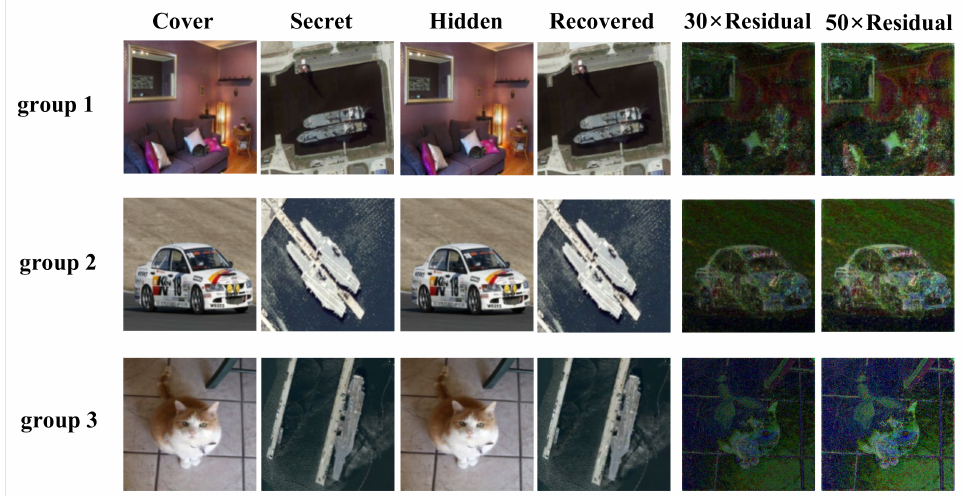
Figure 6. Steganography performance using the new